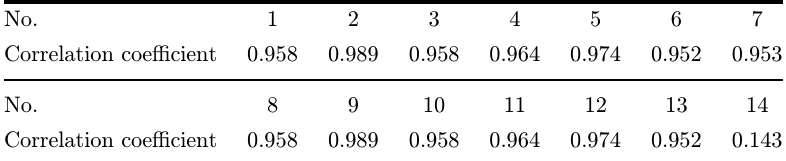
Table 5. Diclofenac sodium near-infrared spectral images correlation coe±cient.